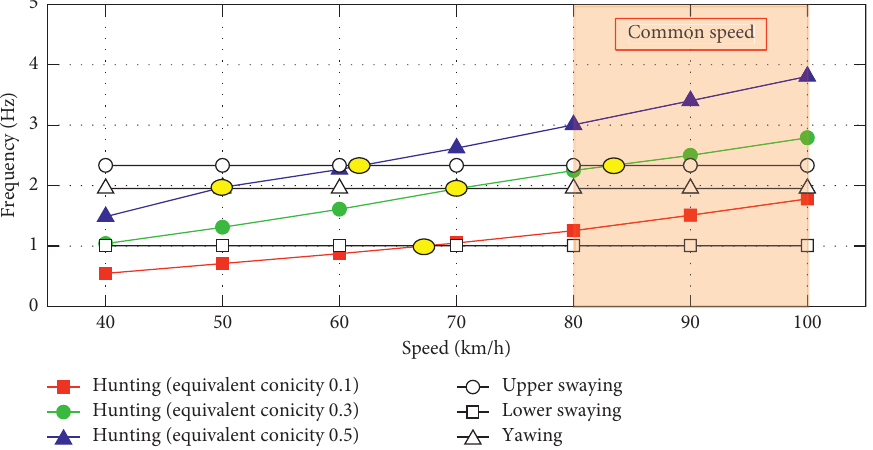
Figure 17: Resonance diagram at different equivalent conicities.